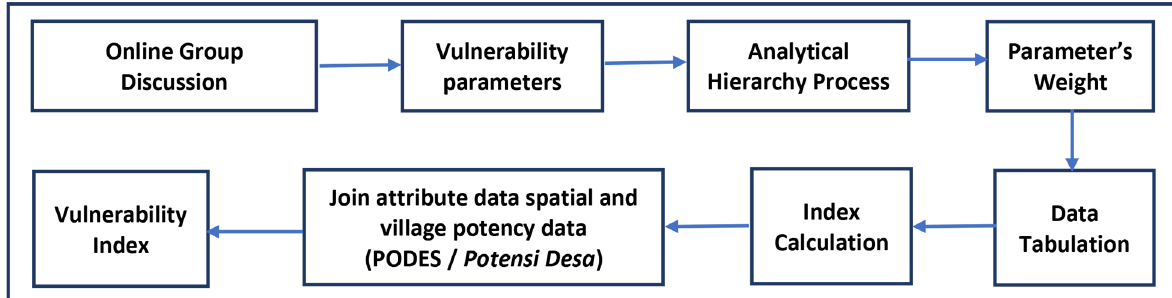
Fig. 4. Vulnerability analysis